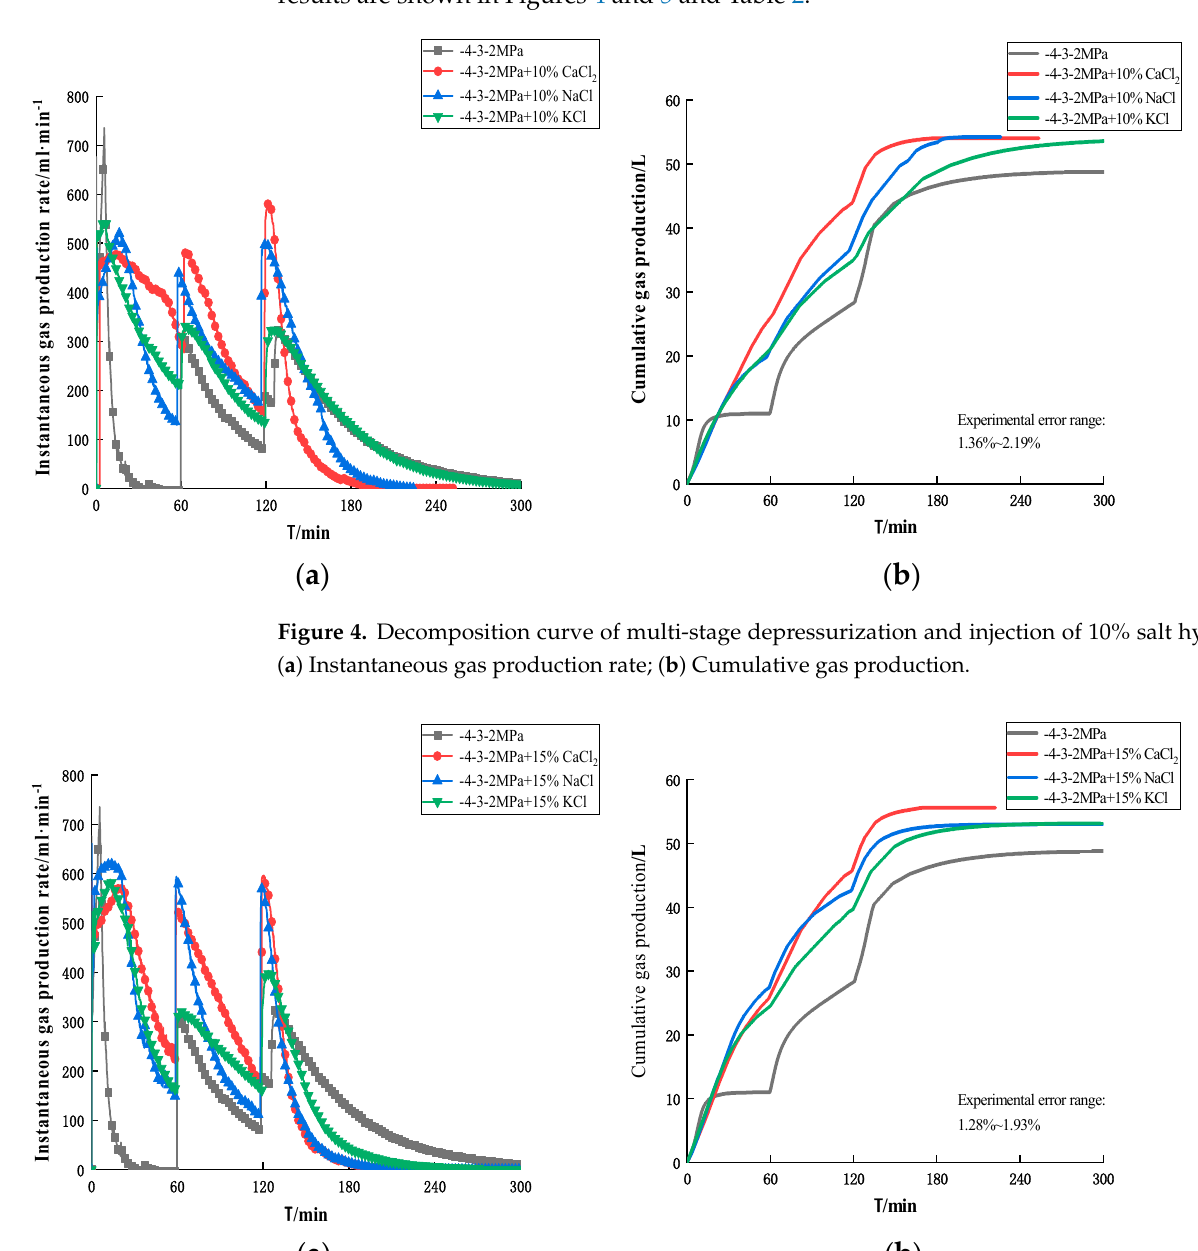
Figure 5. Decomposition curve of multi-stage depressurization and injection of 15% salt hydrate: ( a ) Instantaneous gas production rate; ( b ) Cumulative gas production